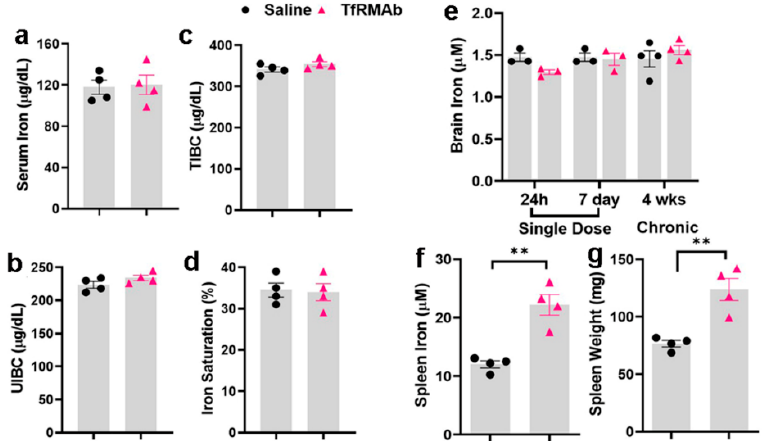
Figure 5. Plasma and organ iron-measurements following acute and chronic dosing of the high-a ffi nity bivalent TfRMAb in mice. Mice were treated three days per week for four weeks with a 3 mg / kg SQ dose of TfRMAb, and plasma iron-indices were measured ( a – d ). Whole-brain tissue iron at 24 h and seven days after acute dosing and four-weeks after chronic TfRMAb dosing ( e ). Spleen-iron and -weights four weeks after chronic TfRMAb dosing ( f , g ). Data are shown as the mean ± SEM of n = 3–4 per group. ** p < 0.01. TIBC: Total-iron binding capacity; UIBC: unsaturated iron-binding capacity.